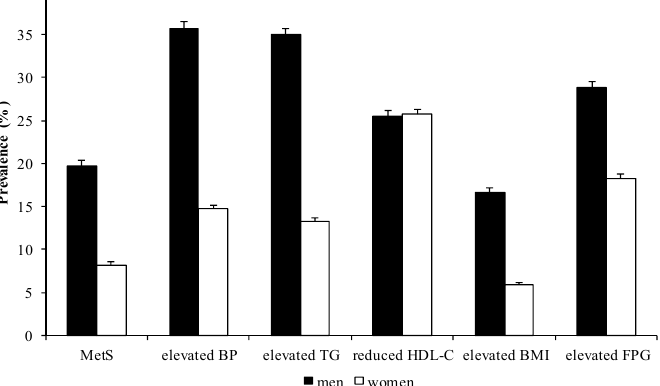
Figure 1. Prevalence of MetS and its components by sex.